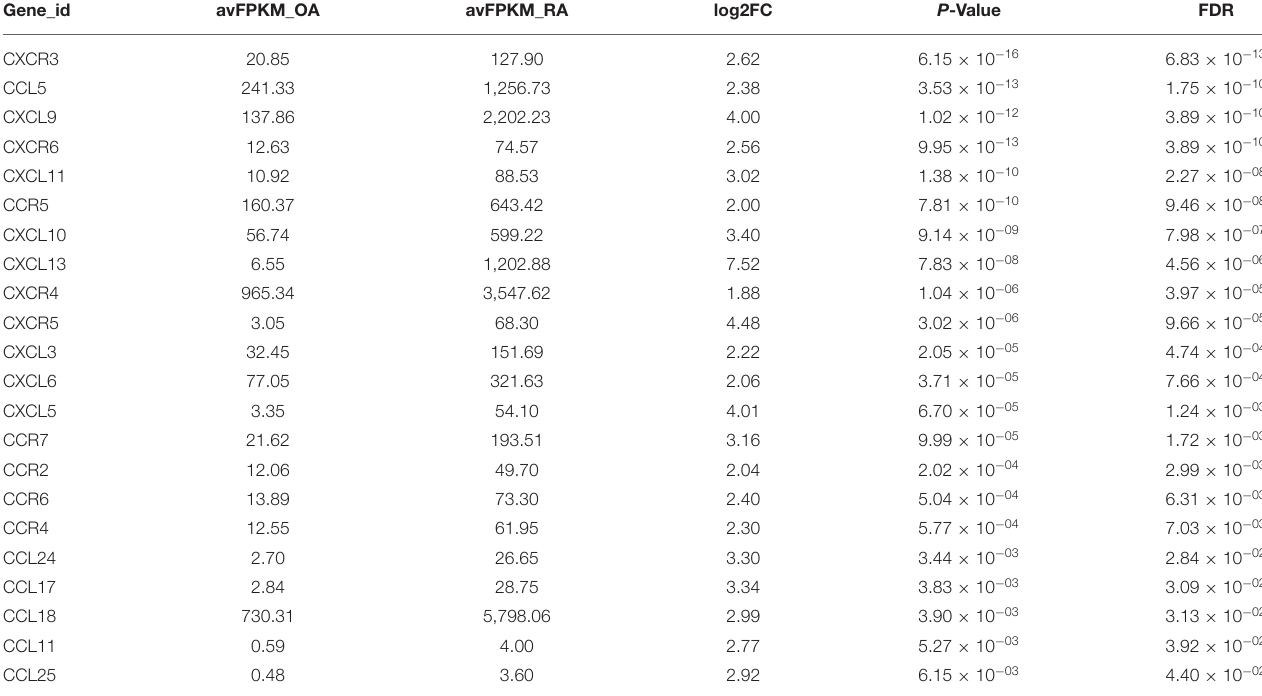
TABLE 3 | Information of the differentially expressed chemokine genes.